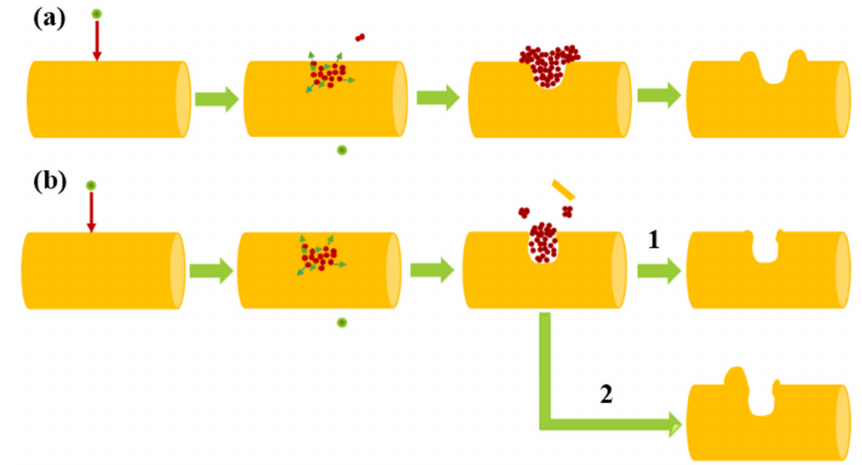
Figure 5. A sketch map of the crater formation mechanism. ( a ) Plastic flow process; ( b ) micro-explosion process, 1 and 2 point out the formation of the crater without and with a protrusion, respectively.